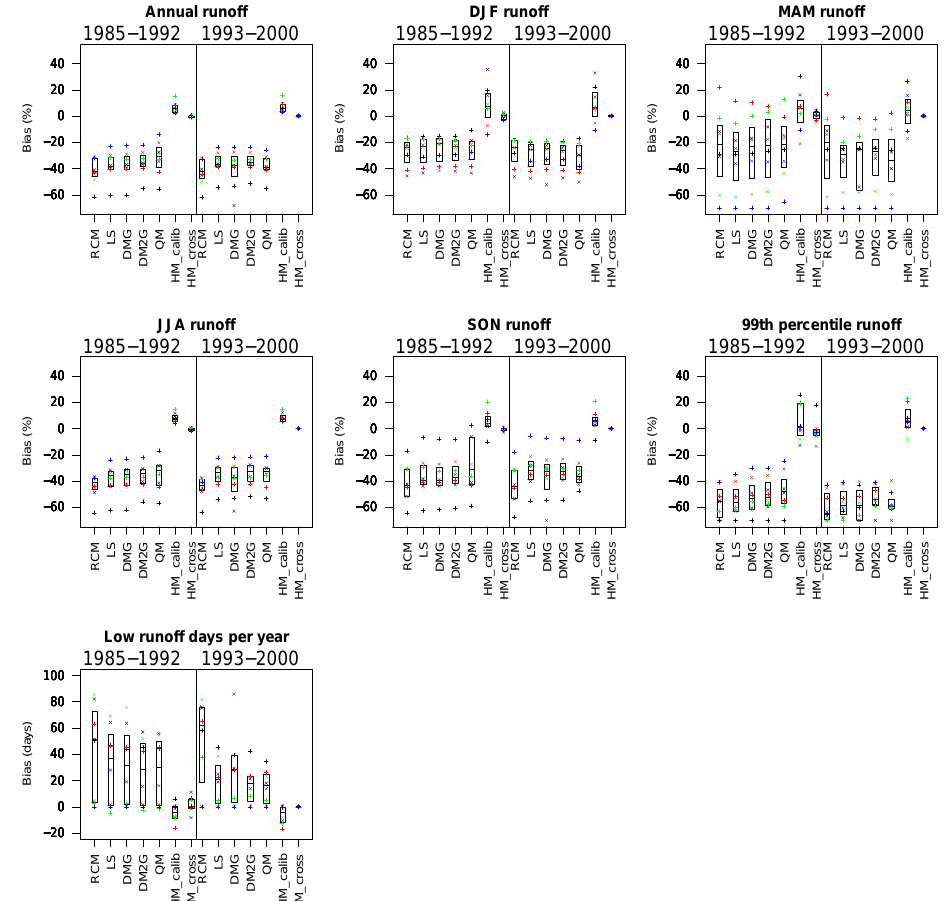
Figure 8. As for Fig. 6, but showing runoff characteristics modelled by GR4J.